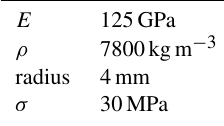
Table 2. Trailing edge cable properties.